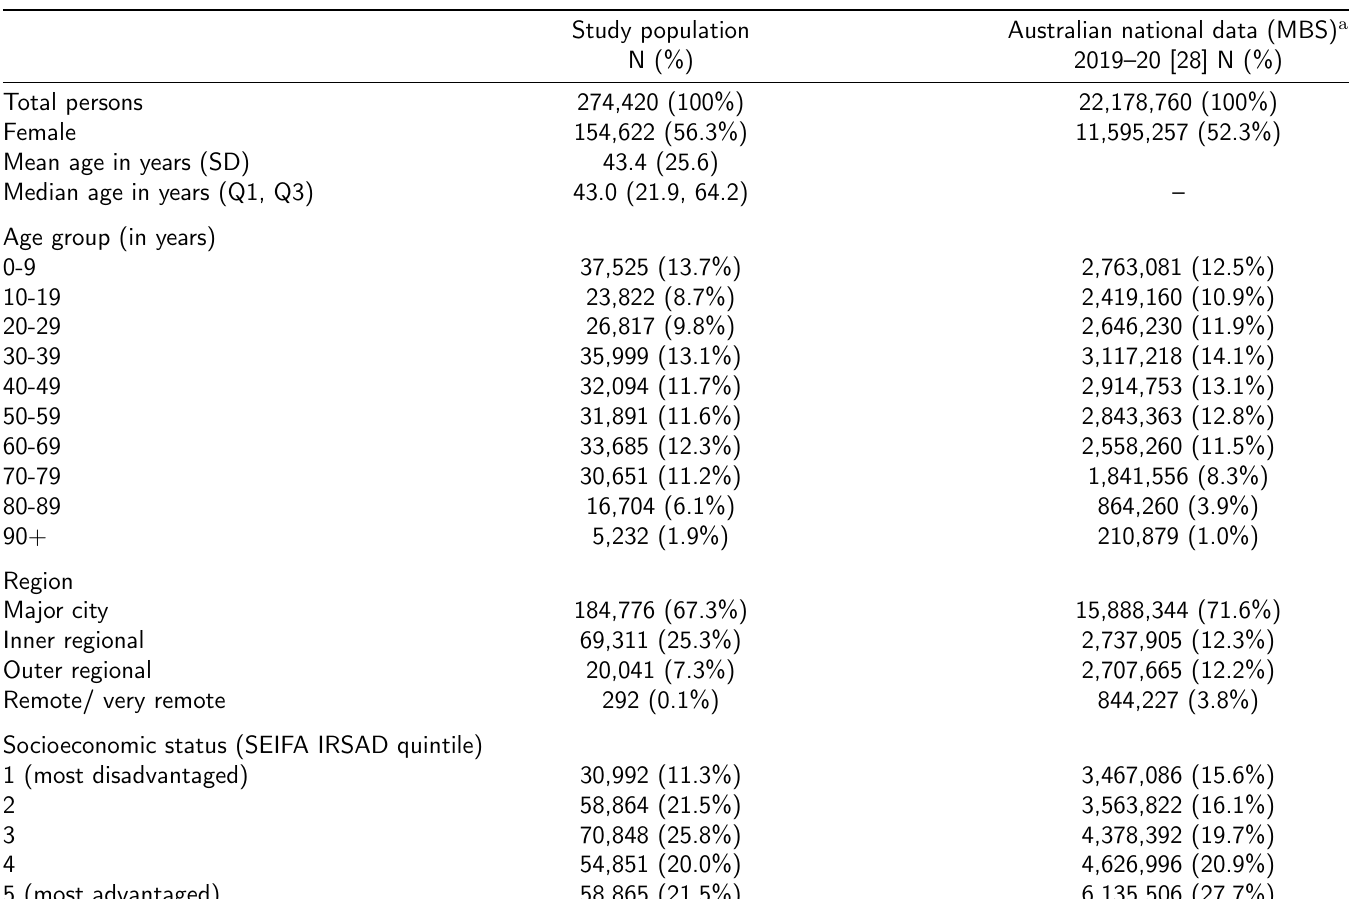
Table 1: Characteristics of the study population